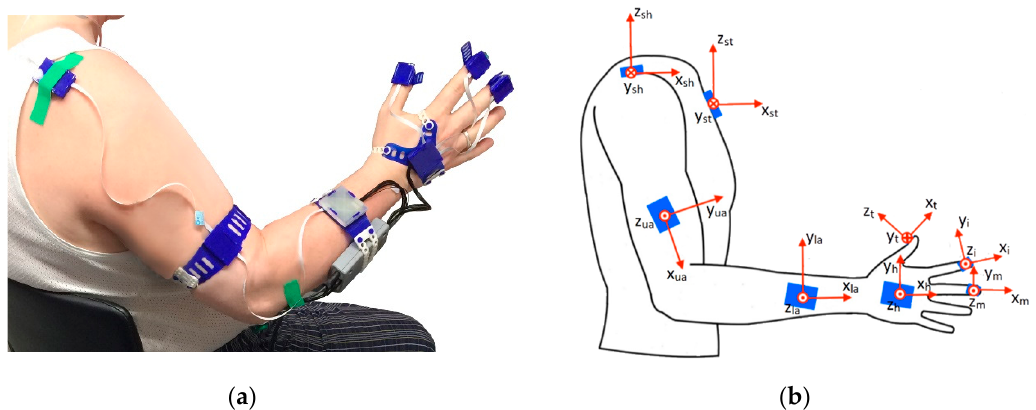
Figure 1. Wearable inertial sensing system: ( a ) system set-up; ( b ) anatomical frame definition per segment.